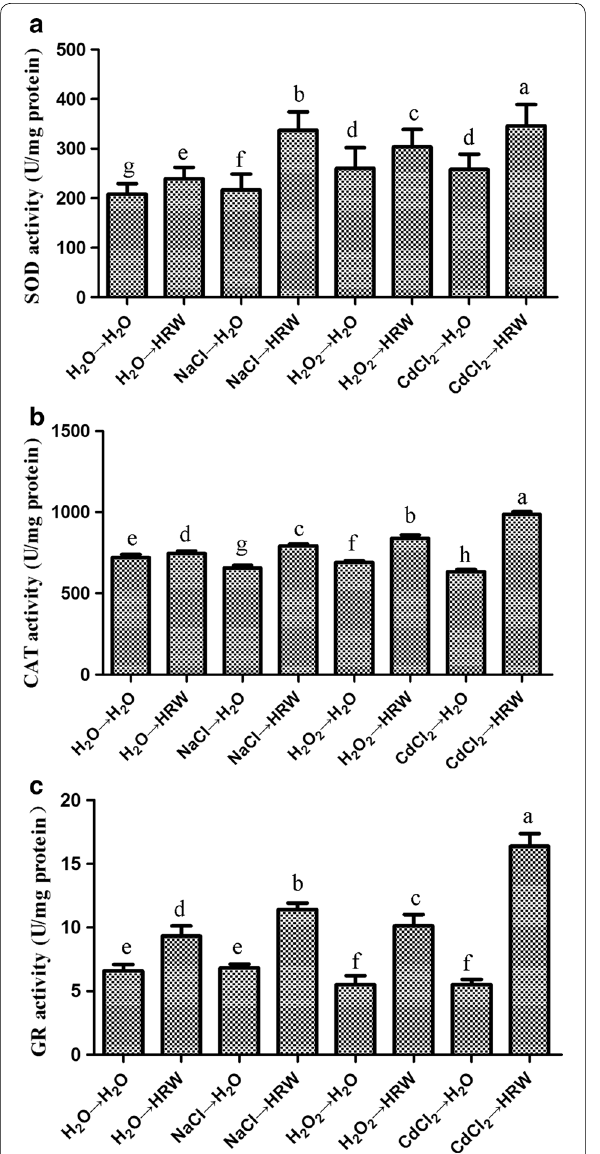
Fig. 4 Effects of HRW treatment on SOD ( a ), CAT ( b ) and GR ( c ) activities in mycelia of Hypsizygus marmoreus upon CdCl 2 , NaCl and H 2 O 2 stresses. The mycelia were pretreated with CdCl 2 , NaCl or H 2 O 2 for 24 h, followed by 48-h incubation with or without HRW. Data are mean SE from three independent experiments. Bars with different ± letters are significantly different at P < 0.05 according to Duncan’s multiple range test